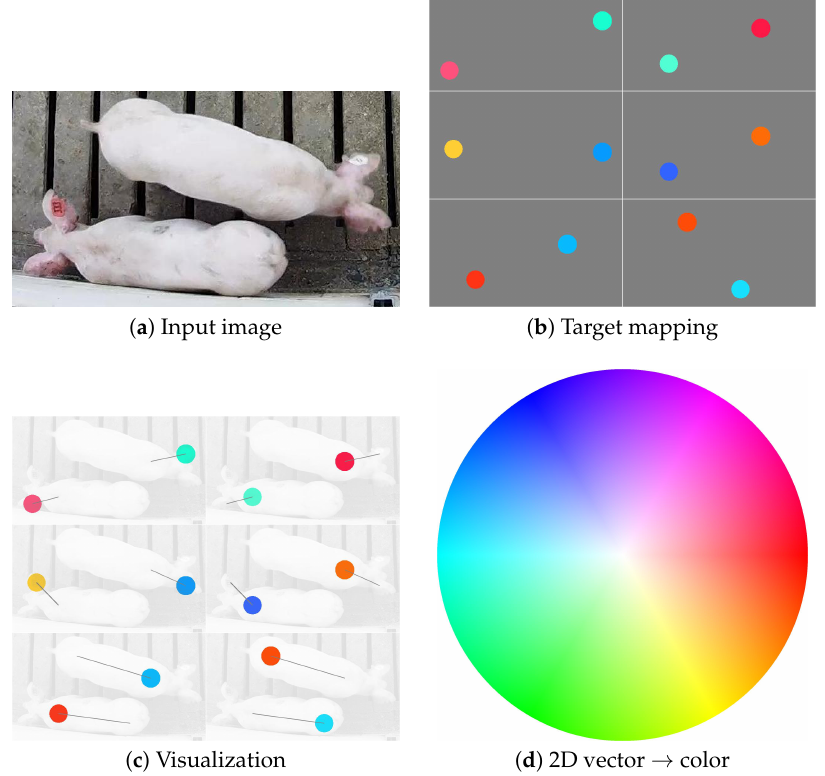
Figure 3. The original image ( a ) is mapped to a 12-channel output ( b ), where vectors joining three pairs of body parts are encoded into circular regions in channels 5–16 of the output. Note that the four colors used in ( b ) are purely for visualization of the direction and magnitude of the vectors, where ( d ) provides a mapping between vectors and colors. The overlay in ( c ) is provided to illustrate the locations of the vector encodings and their magnitude and direction (illustrated by the gray line) in relation to the original